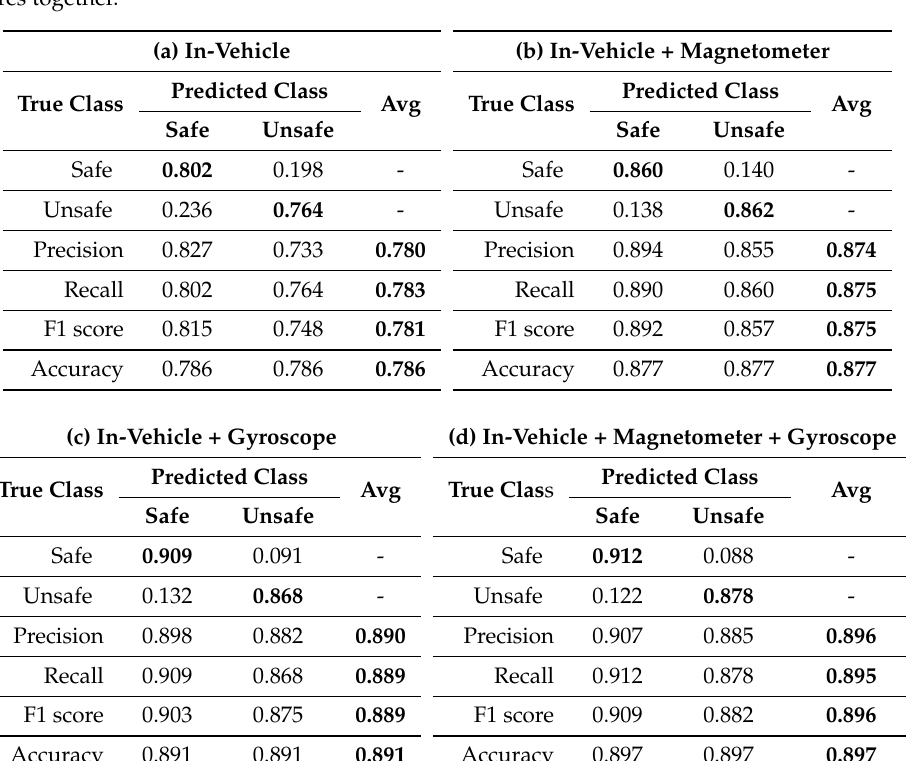
Table 2. Confusion matrices and classification performance of the proposed neural network while trying to distinguish safe and unsafe driver behaviors when varying the adopted features. Table ( a ) reports the results obtained with only in-vehicle sensors’ features; Table ( b ) with in-vehicle sensors and gyroscopic features; Table ( c ) with in-vehicle sensors and magnetometer features; and Table ( d ) with all features